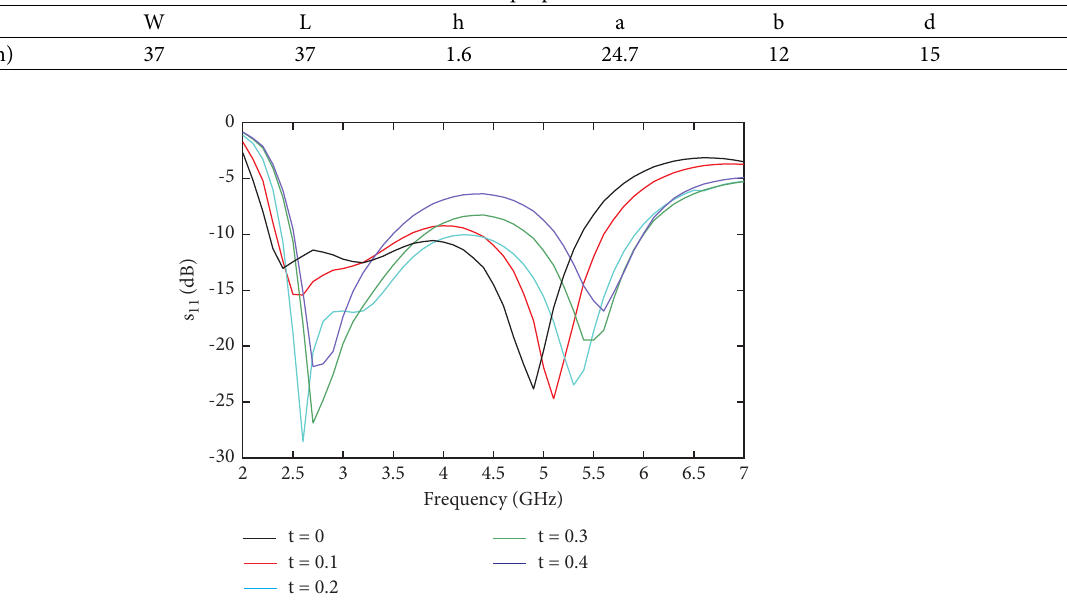
Table 1: Dimensions of the proposed antenna.